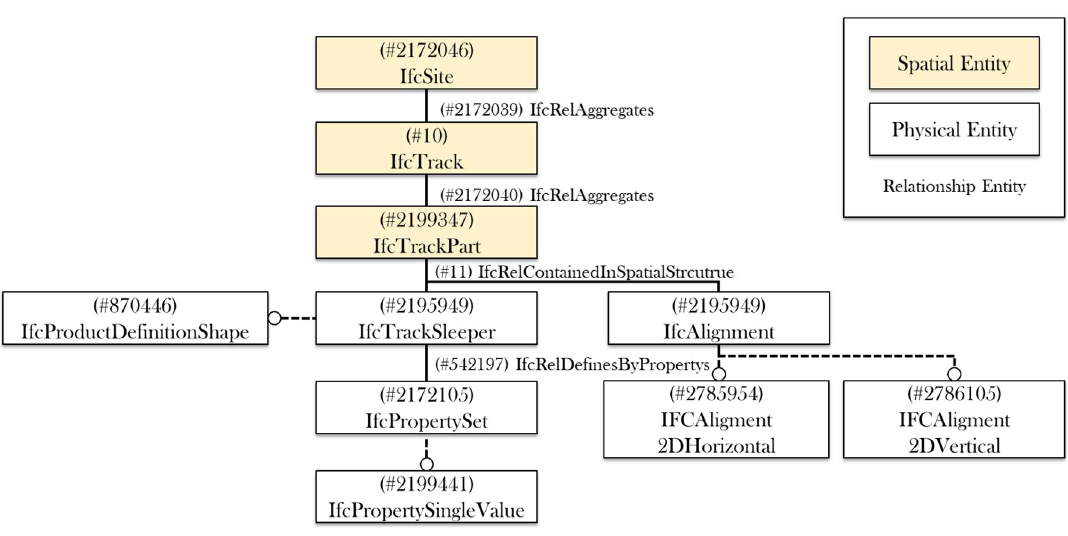
Figure 12. EXPRESS-G of the IFC-based railway track model.